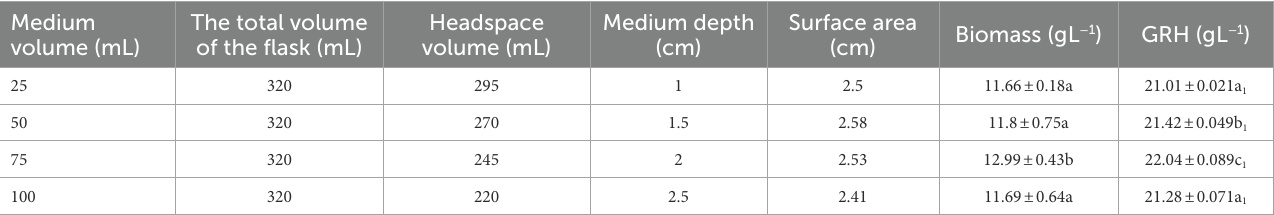
TABLE 2 Effect of medium volume, headspace volume, and medium depth on the dissolved oxygen level in the fermentation medium and their effect on GRH and biomass production. Medium volume (mL)